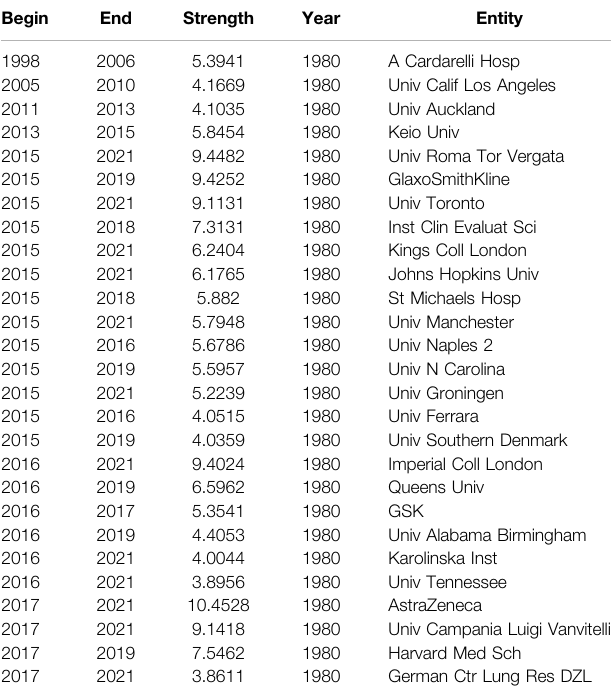
TABLE 1 | Top 27 institutions with the strongest citation bursts that published COPD drugs-related studies from 1980 to